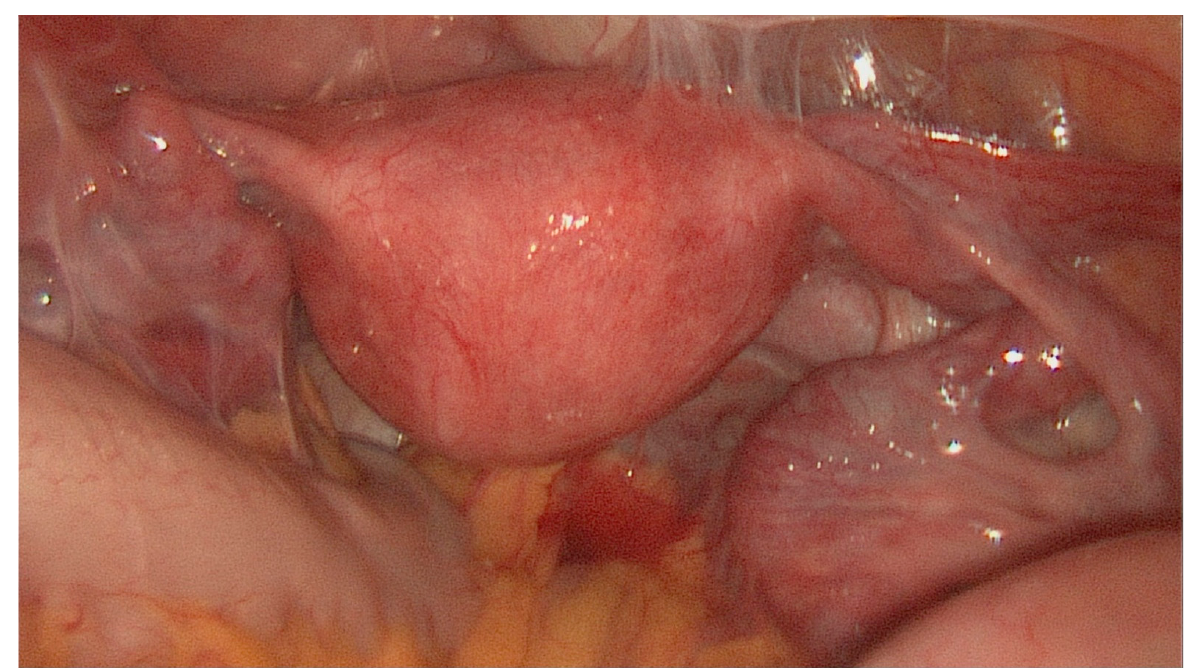
Figure 3. Severe tubal disease according to classification by Hull and Rutherford.